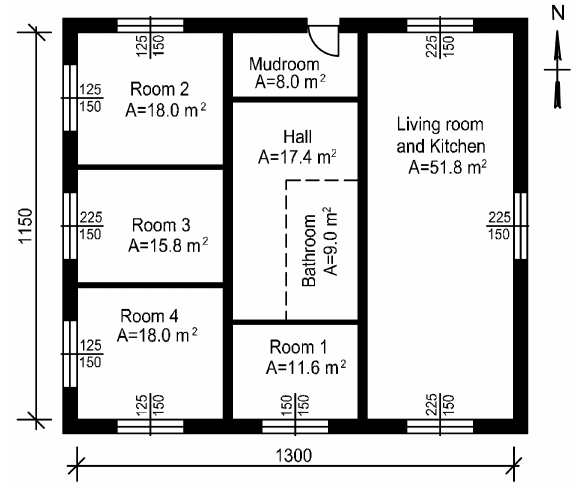
Figure 5. Ground floor